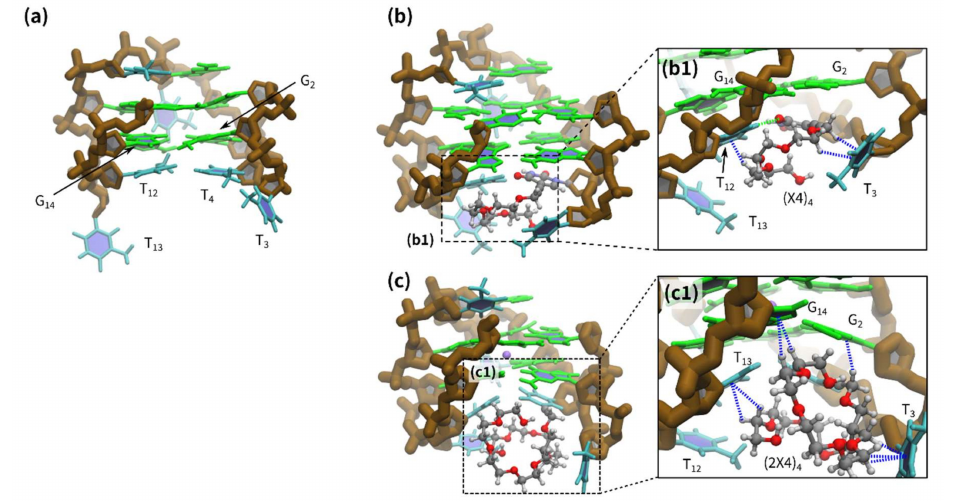
Figure 3. Representative structures of ( a ) Q1 at 50 ns, ( b ) Q1-(X4) 4 at 34 ns, and ( c ) Q1-(2X4) 4 at 133 ns and (b1 and c1) enlarged views of the dashed squares. Green, cyan, and brown illustrate guanine, thymine, and the backbone of the G-quadruplex, respectively. The red, blue, gray, and white colors of the ball-and-stick models illustrate oxygen, nitrogen, carbon, and hydrogen atoms, respectively. The expected hydrogen bond and CH- π interactions between TEG and the oligonucleotide are indicated by green and blue dashed lines,